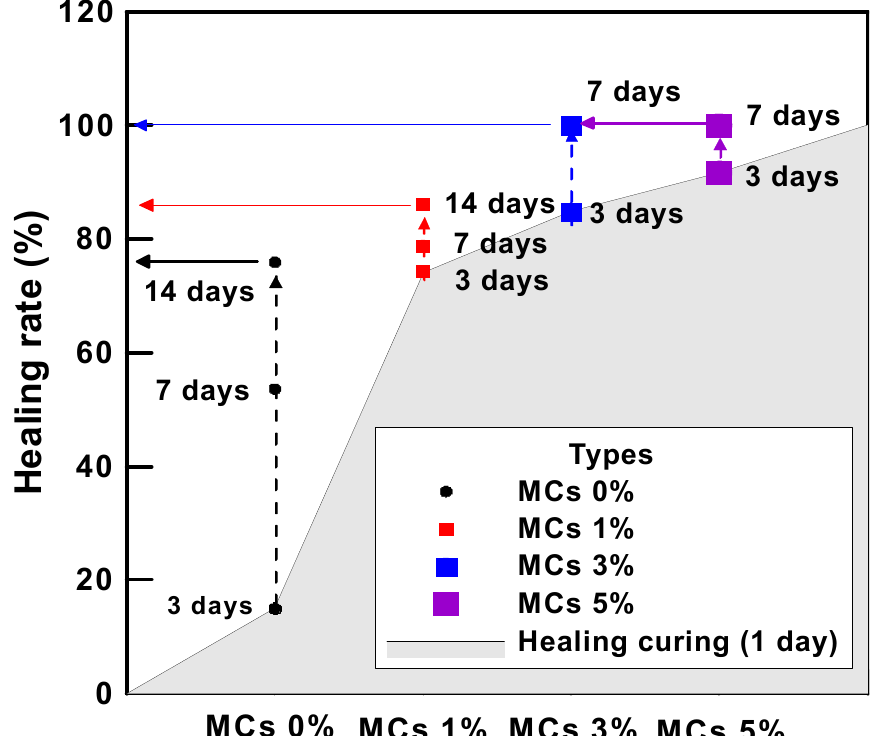
Figure 15. Time required for healing for each type.